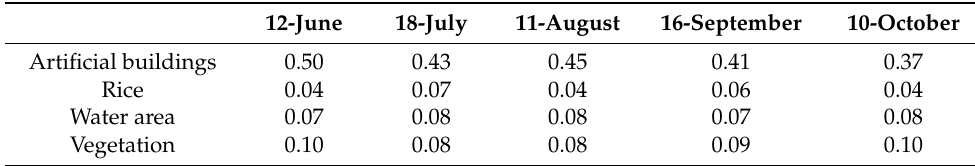
Figure 14. Sentinel-1 VH polarization coherence coefficient map. Table 4. Coherence coefficient of VH polarization.